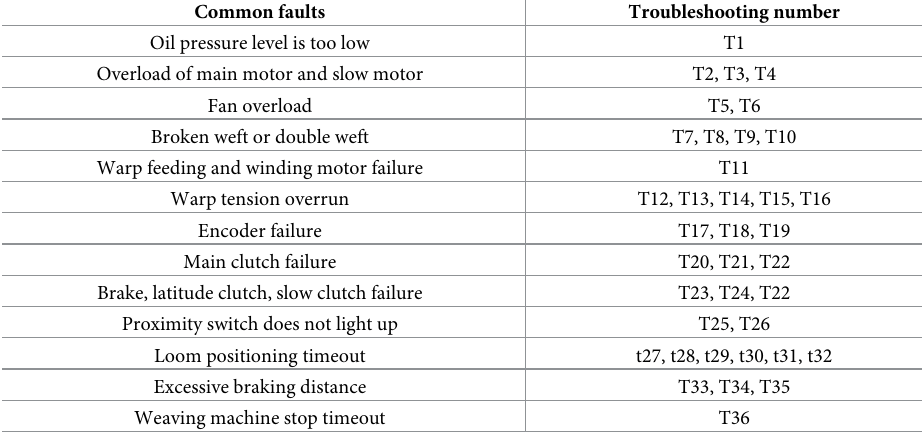
Table 3. Common faults of rapier looms and their repair